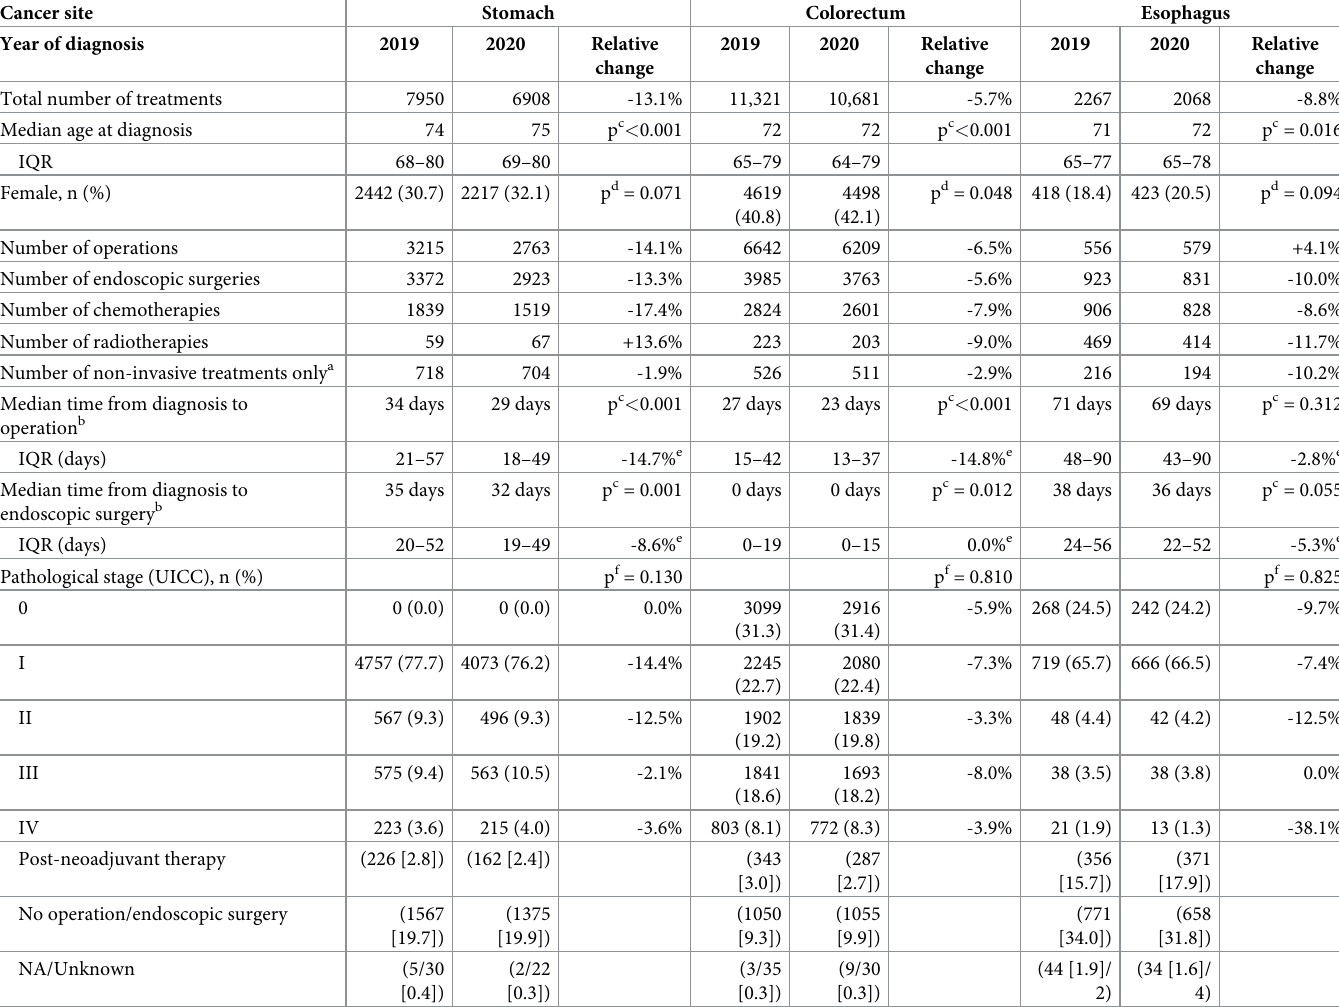
Table 3. Treatment patterns and pathological stage in patients with six digestive cancers in the CanReCO project. Cancer